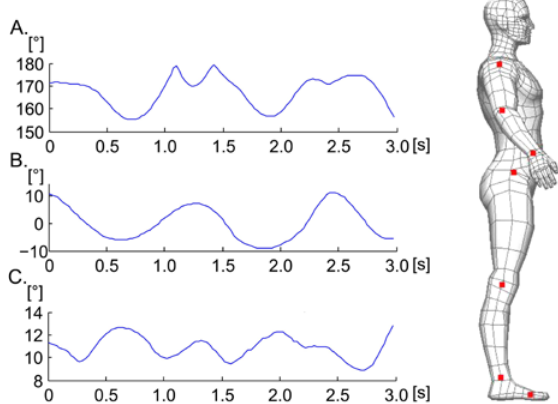
Figure 1. Example of angle-time diagrams of upper limb joint angles and marker placement; A. elbow angle in sagittal plane, B. shoulder angle in sagittal plane, C. shoulder angle in frontal